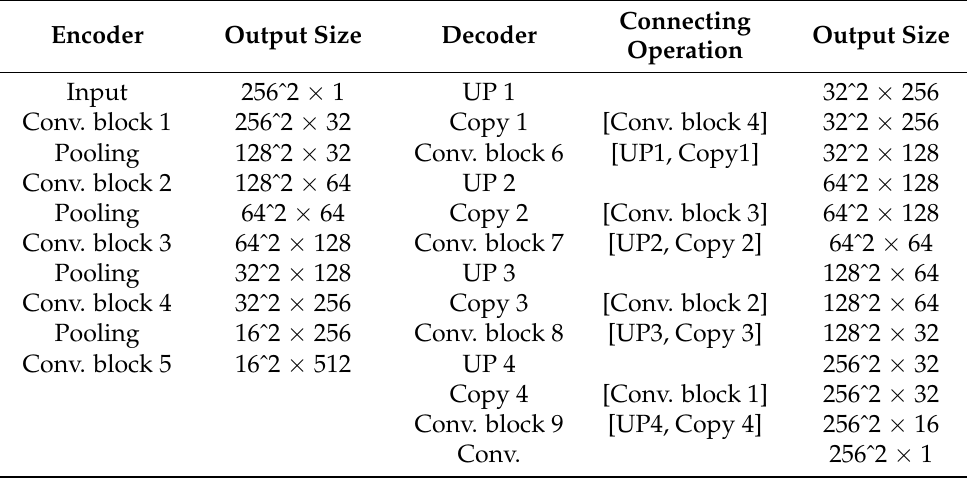
Table 1. Architecture of SED-1 (Conv. stands for convolution, UP means up-sampling, [ ] denotes long range connection, [ ˆ ] denotes superscript, and [ , ] denotes concatenate